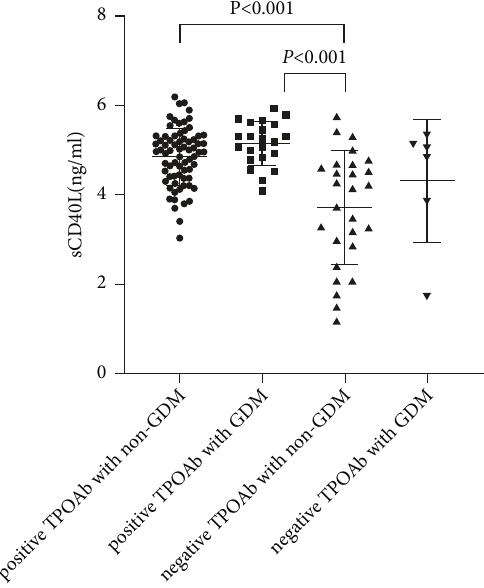
Figure 4: The comparison of sCD40L according to TPOAb pos- itivity and the clinical fate of GDM. Comparison of sCD40L levels between the four groups was performed by ANOVA test and Bonferroni correction was used for post hoc Table 3: Multivariable logistic regression analysis of risk factors for GDM in pregnant women with positive TPOAb.